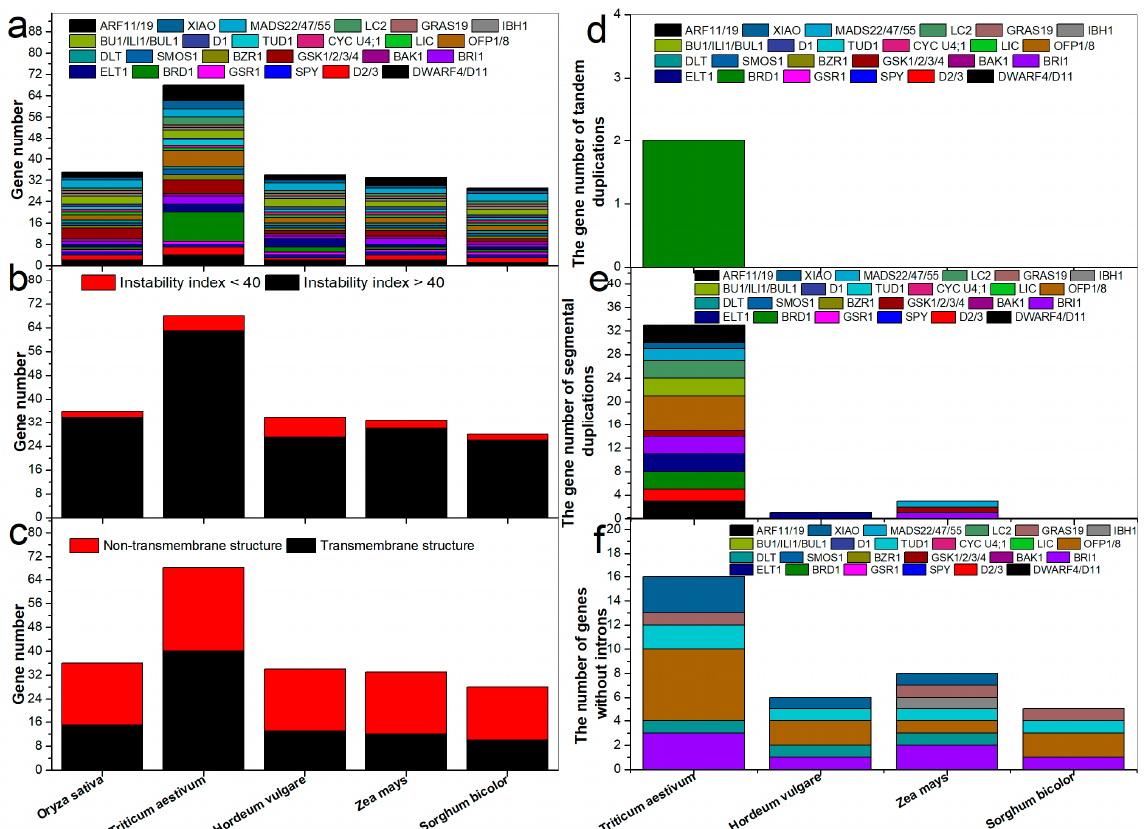
Figure 1. Number of BR-related genes among different species. ( a ) Gene number of each BR-related plant architecture gene in rice and four Gramineae species. ( b ) Instability index of BR-related plant architecture genes in rice and four Gramineae species. ( c ) Transmembrane structure of BR-related plant architecture genes in rice and four Gramineae species. ( d ) Gene number of tandem duplications. ( e ) Gene number of segmental duplications. ( f ) Number of genes without introns.